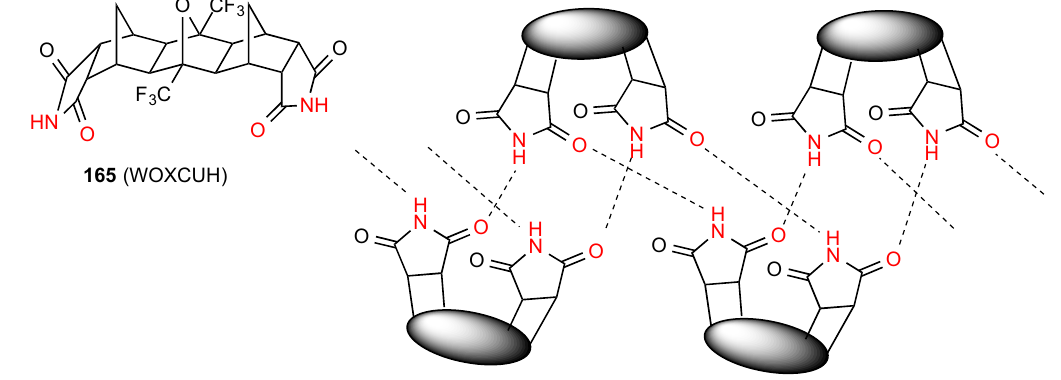
Figure 50. Structure adopted by compound 165.